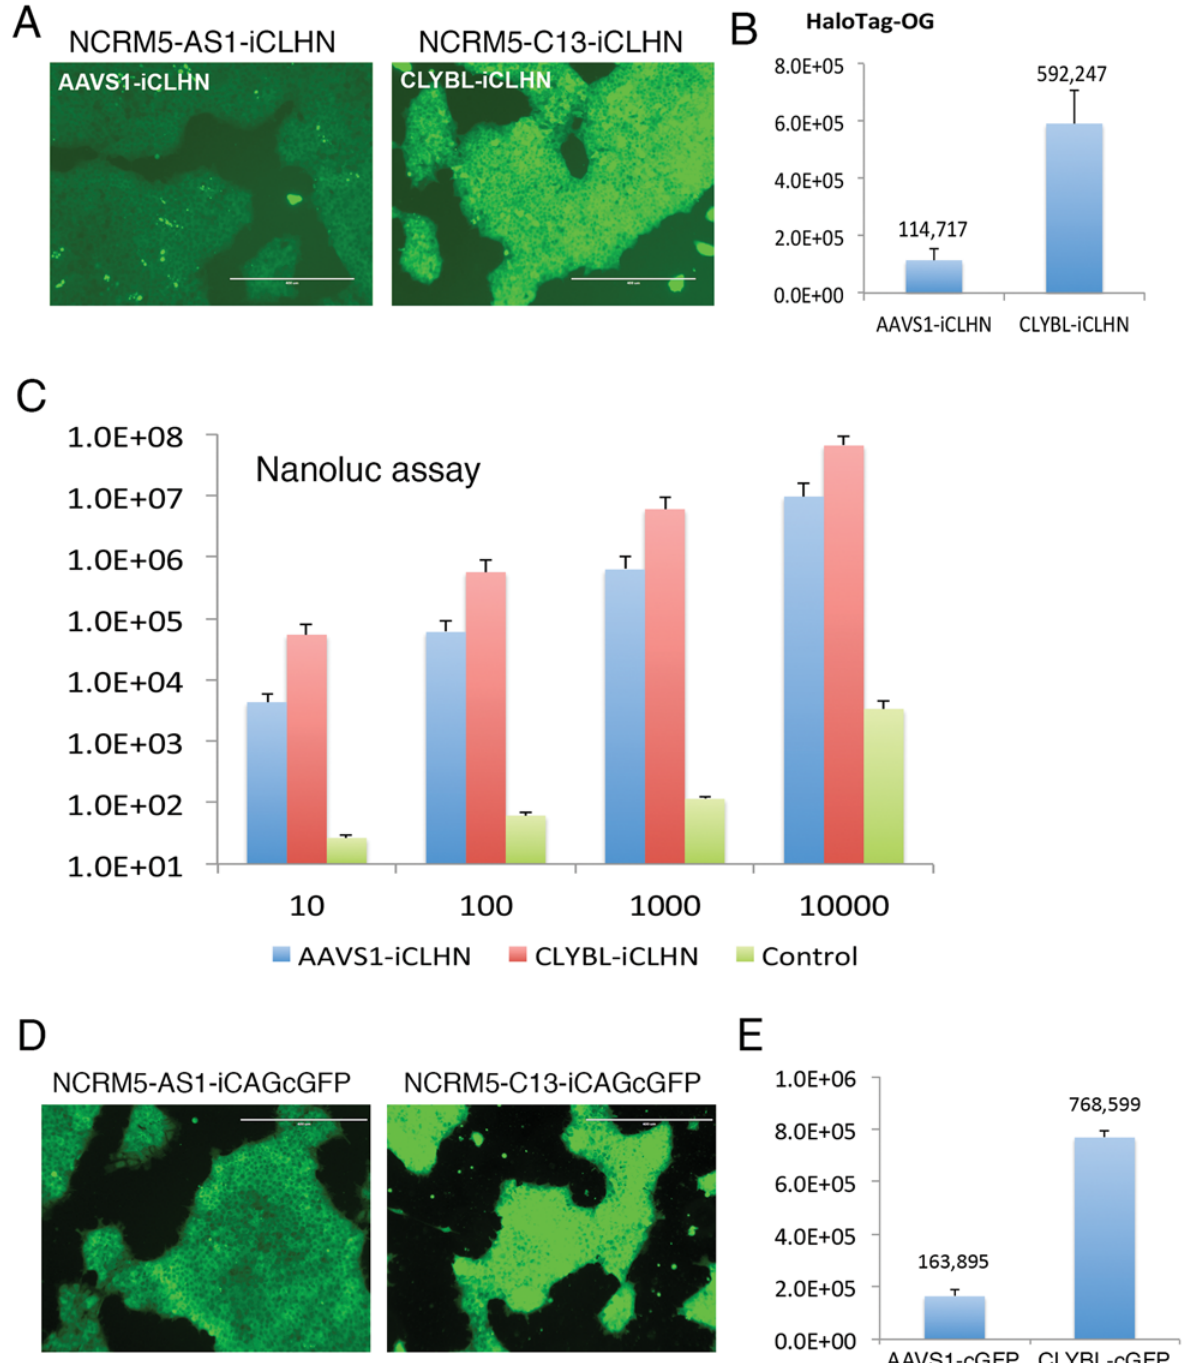
Figure 2. CLYBL safe-harbor enables heightened expression of transgenes. (A) Oregon green stained human iPSC clones with Nanoluc-HaloTag integrated in the AAVS1 (AAVS1-iCLHN) or the CLYBL (CLYBL-iCLHN) safe-harbor bi-allelically without RI. Scale bar = 400 μ m. (B) Comparison of HaloTag expression between AAVS1 (AAVS1-iCLHN) and CLYBL (CLYBL-iCLHN) targeted NCRM5 iPSC clones using Oregon green (OG) ligand staining and flow cytometry. Y-axis = mean fluorescence intensity (MFI). Error bar = S.E.M. N = 3 (C) Nanoluc activity comparison of bi-allelically targeted AAVS1-iCLHN or CLYBL-iCLHN clones with untargeted NCRM5 control iPSCs. Y-axis is relative luciferase unit (RLU). X-axis is cell number. Data shown are the averages of 3 repeated measurements of three AAVS1-iCLHN clones, three CLYBL-iCLHN clones and one parental NCRM5 clone. Error bar = S.E.M. (E) Representative fluorescent images of CAG-driven copGFP expression in AAVS1 (NCRM5-AS1-iCAGcGFP) or CLYBL (NCRM5-C13-iCAGcopGFP) targeted iPSC clones. Scale bar = 400 μ m. (F) Quantitative comparison of copGFP expression between mono-allelically AAVS1 targeted (AAVS1-cGFP) and CLYBL targeted (CLYBL-cGFP) clones. Y-axis = MFI. Error bar = S.E.M. N = 2. doi:10.1371/journal.pone.0116032.g002 PLOS ONE | DOI:10.1371/journal.pone.0116032 January 14,